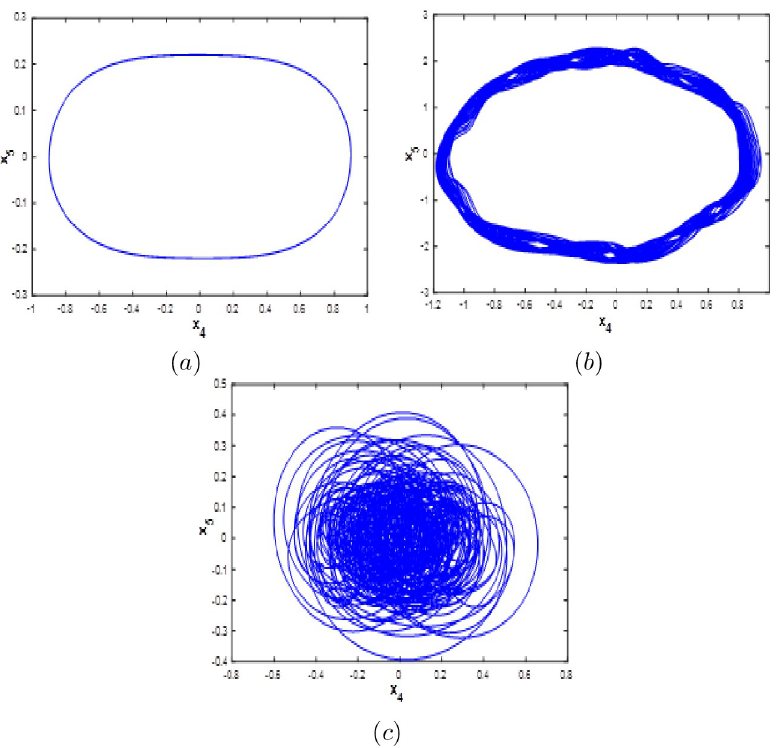
Fig 8. Phase portraits of the new 10-D system (1) for different values of c . (a) x 4 − x 5 Periodic attractor, (b) (a) x 4 − x 5 chaotic attractor and (c) (a) x 4 − x 5 hyperchaotic attractor.